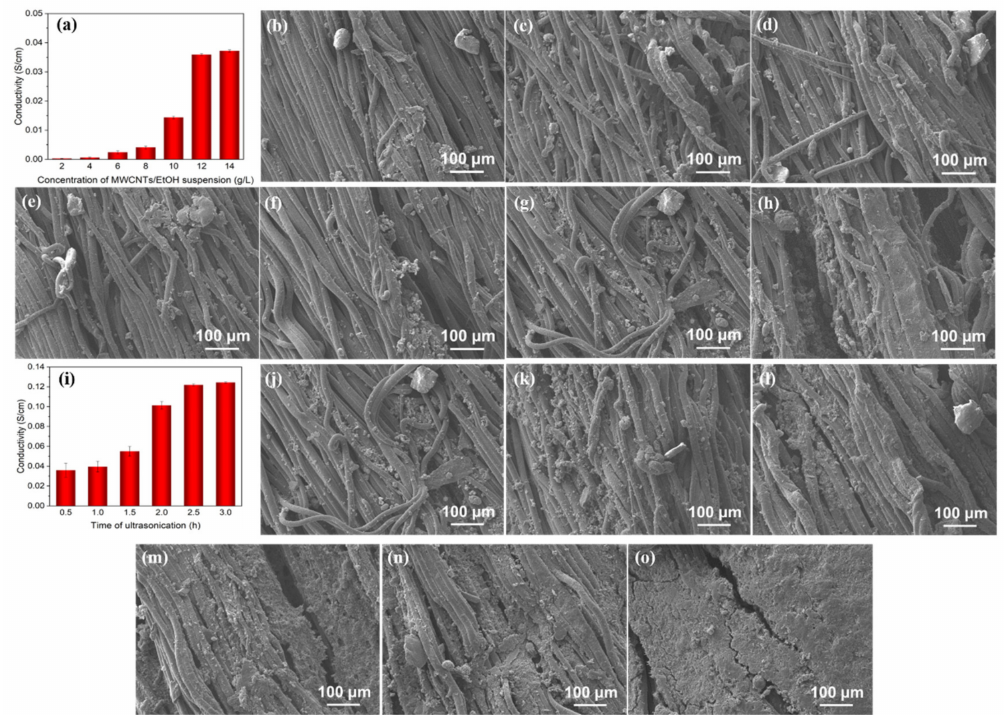
Figure 4. ( a ) Conductivity of PDA@SEBS/MWCNTs yarns; ( b – h ) SEM images of PDA@SEBS/ MWCNTs yarn coated with MWCNTs/EtOH suspension concentrations of ( b ) 2 g/L, ( c ) 4 g/L, ( d ) 6 g/L, ( e ) 8 g/L, ( f ) 10 g/L, ( g ) 12 g/L and ( h ) 14 g/L; ( i ) Conductivity of PDA@SEBS/MWCNTs yarn; ( j – o ) SEM images of PDA@SEBS/MWCNTs sonicated for ( j ) 0.5 h, ( k ) 1 h, ( l ) 1.5 h, ( m ) 2 h, ( n ) 2.5 h, and ( o ) 3 h.